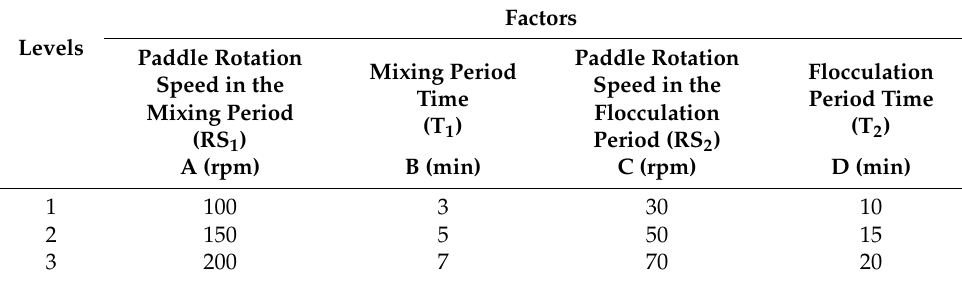
Table 1. Factors and levels in the orthogonal array design.